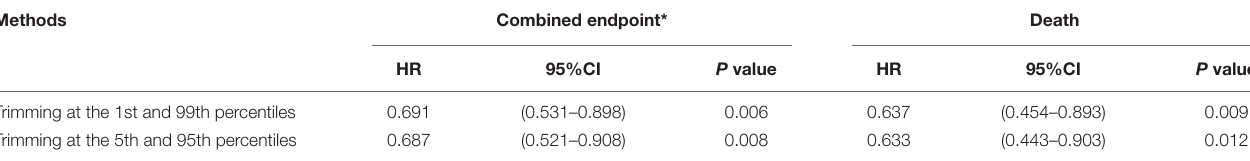
TABLE 3 | Results of the inverse-probability-of-treatment weighting analysis with trimming.